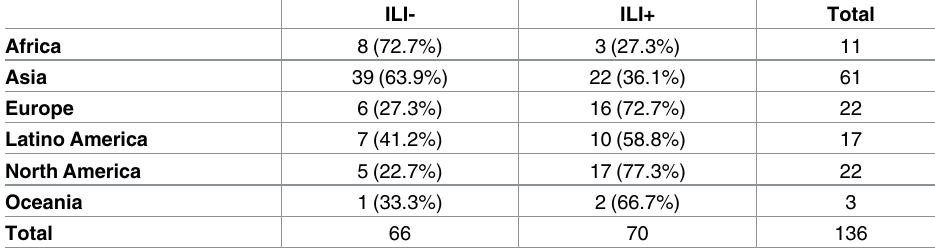
Table 5. Number of studies according to continent and ILI